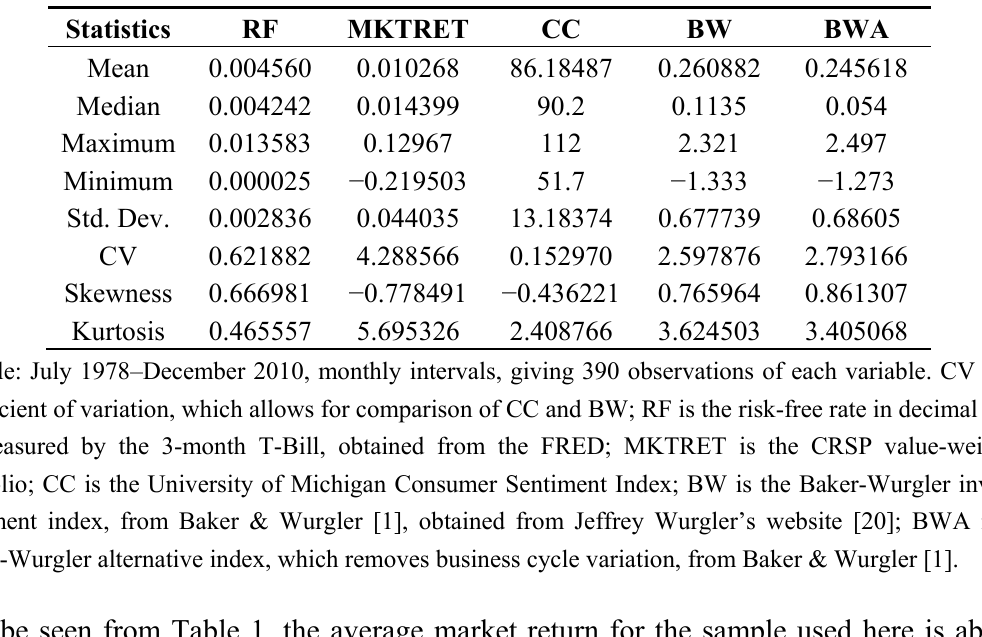
Table 1. Descriptive